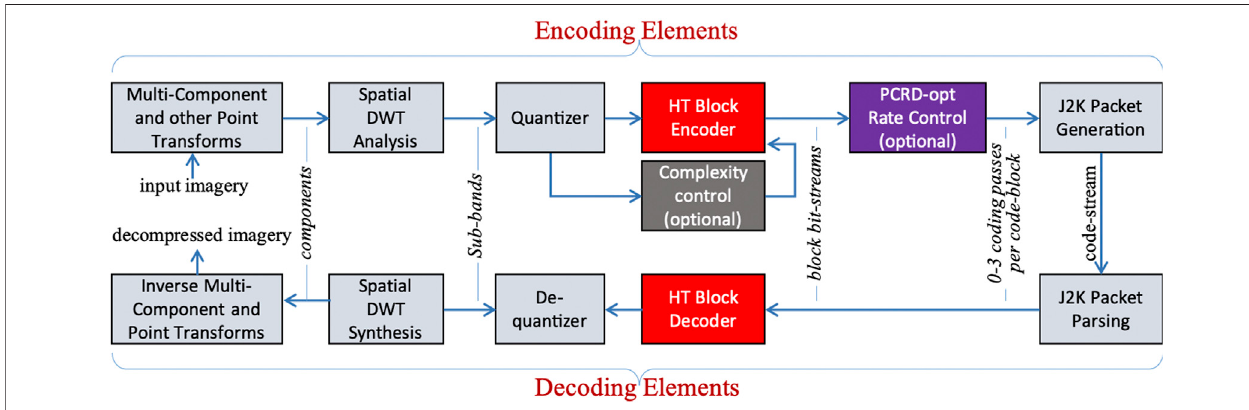
FIGURE 4 | HTJ2K encoding system based on FBCOT (Fast Block Coding with Optimized